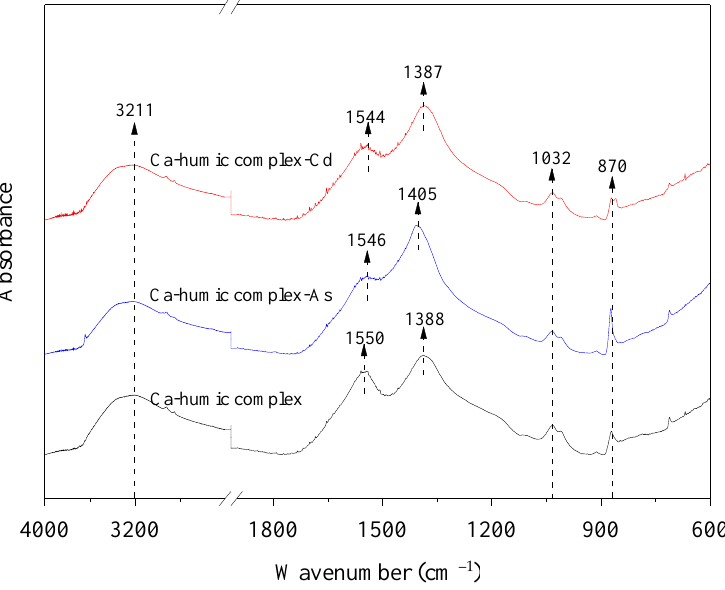
Figure 1. FTIR spectra of the Ca-humic complex before and after adsorbing Cd and As.